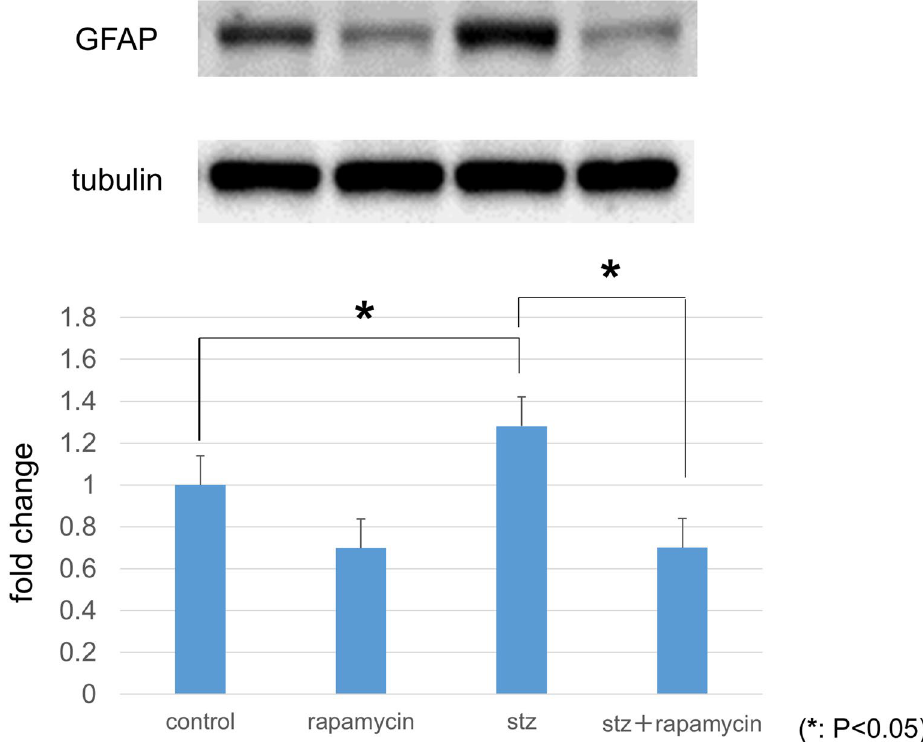
Figure 4. Protein levels of GFAP in retinas determined with Western blotting. GFAP expression was significantly higher in retinas obtained from STZ-induced diabetic rats than from nondiabetic controls. The increased GFAP expression was suppressed by rapamycin ( P < 0.05, n = 3 each).